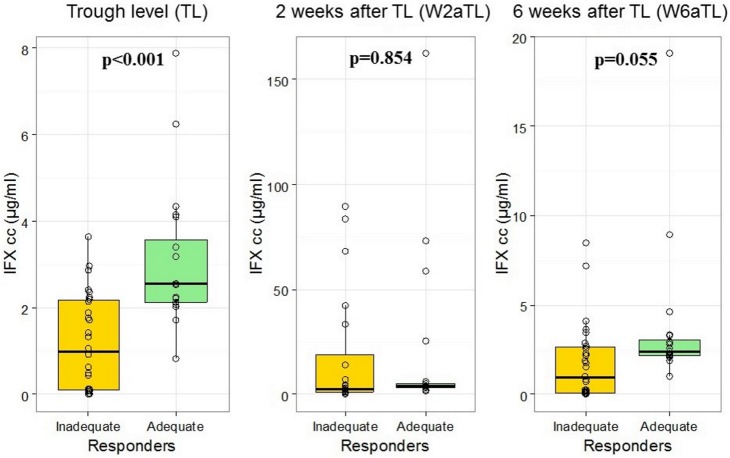
Serum IFX levels immediately prior the administration of regular maintenance infliximab (IFX) infusion (trough level, TL), as well as 2 (W2aTL) and 6 weeks (W6aTL) afterwards in the adequate and inadequate responder group.